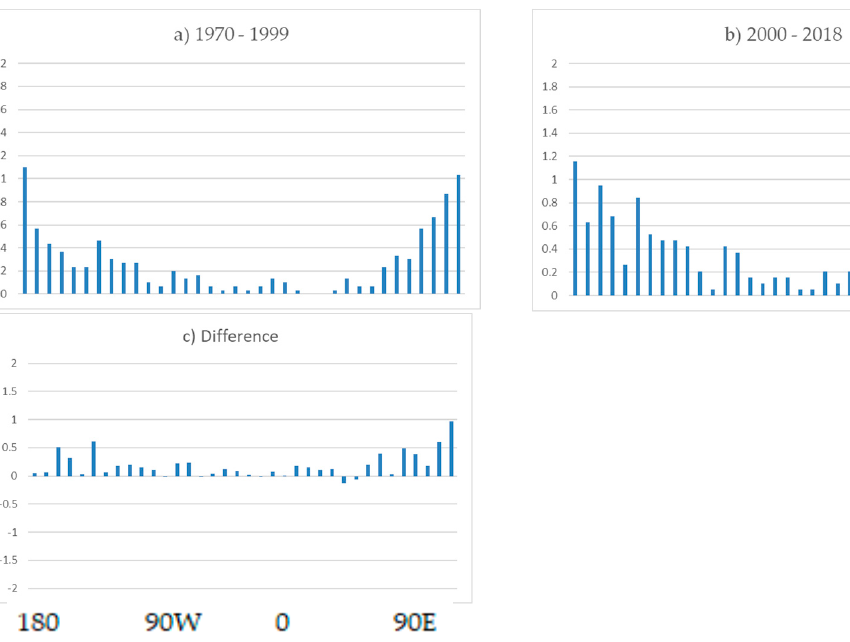
Figure 2. As in Figure 1, except for the SH. 284